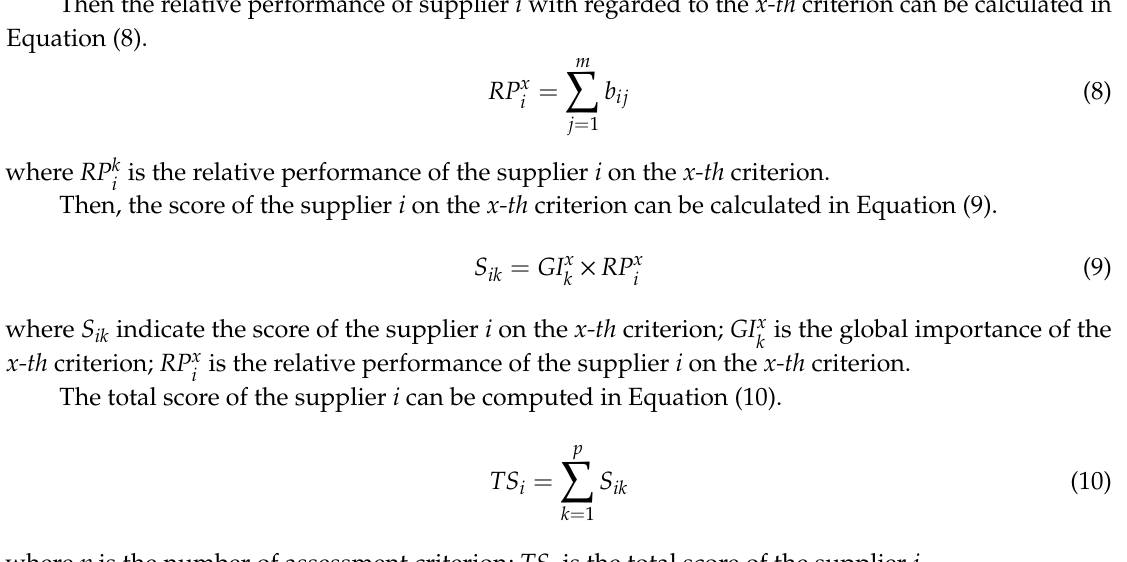
Figure 3. ( a ) The BIM model for the prefabrication project; ( b ) prefabrication components; ( c ) an example of prefabrication wall panel supported on the construction site.